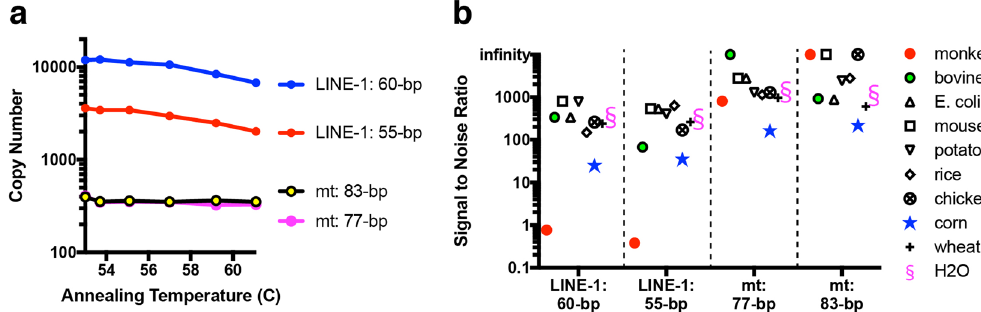
Figure 1. Optimisation of PCR assay conditions and specificity assessment for the faecal human DNA ddPCR assays. ( a ) Annealing temperature optimisation and ( b ) DNA specificity evaluation of two sets of ddPCR primers targeting human LINE-1 elements and two sets of ddPCR primers targeting human mt genes. ( a ) 80 pg of total stool DNA extracted from a human stool sample was used as template in all four gradient PCR reactions. ( b ) S/N ratio represents ACN obtained from 80 pg of total stool DNA extracted from a human stool sample, compared to ACN from 80 pg of purified gDNA from various animal, plant, and bacterial sources, as well as water. The calculation of signal to noise ratios is defined in the